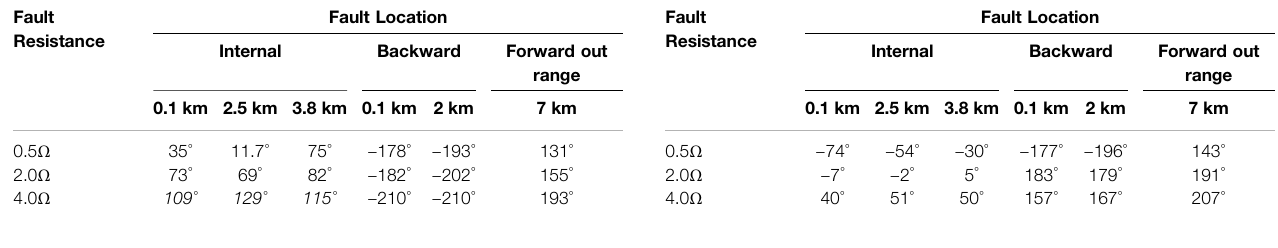
TABLE 1 | Simulation Result of phase BC fault occurring under the protection operation in receiving end. Fault Resistance